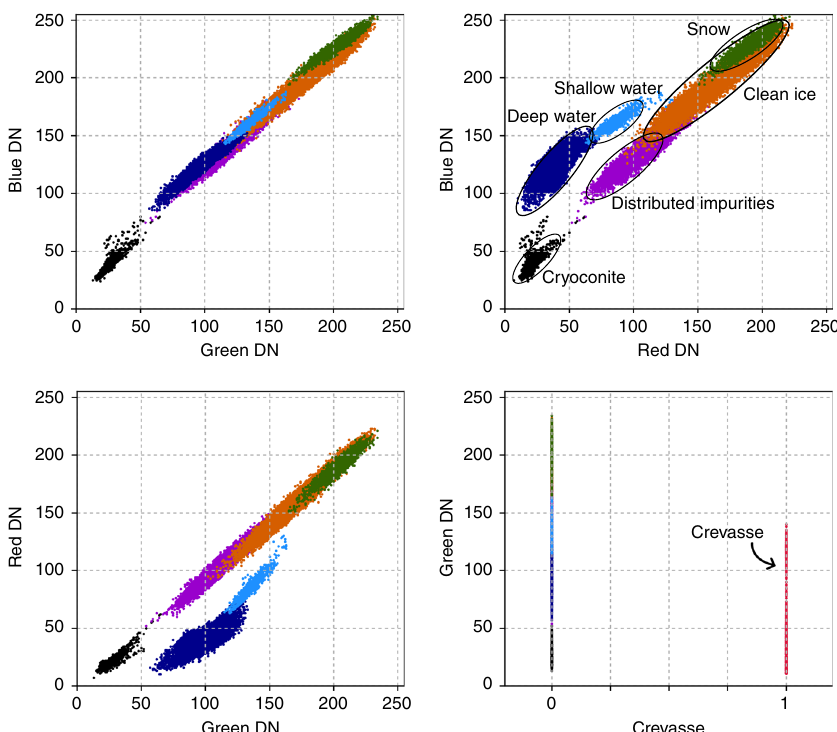
Fig. 7 Scatter-plots showing the key attributes of the seven surface types identi fi ed in this study. DN is digital number of the Sony NEX-5N calibrated RAW image. Deep and shallow supraglacial water is easily distinguishable because it has low re fl ectivity in the red band and forms a unique cluster in the feature space. Snow, clean ice, ice containing distributed impurities and cryoconite form another cluster and are distinguishable because they re fl ect different proportions of RGB visible